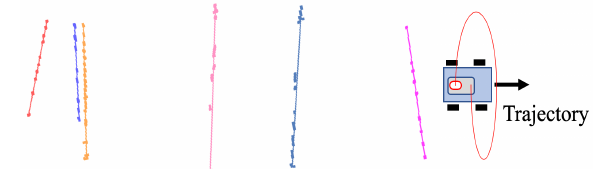
Figure 11. Straight lines crossing the road